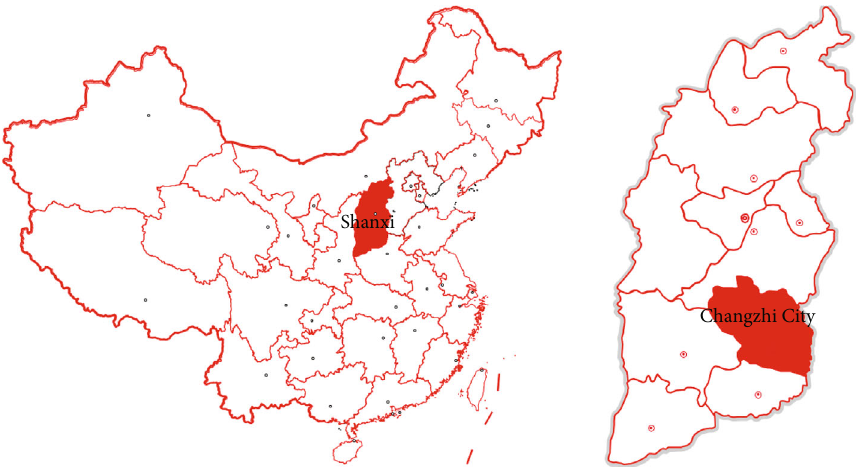
Figure 2: Sampling site of specimens to be tested.